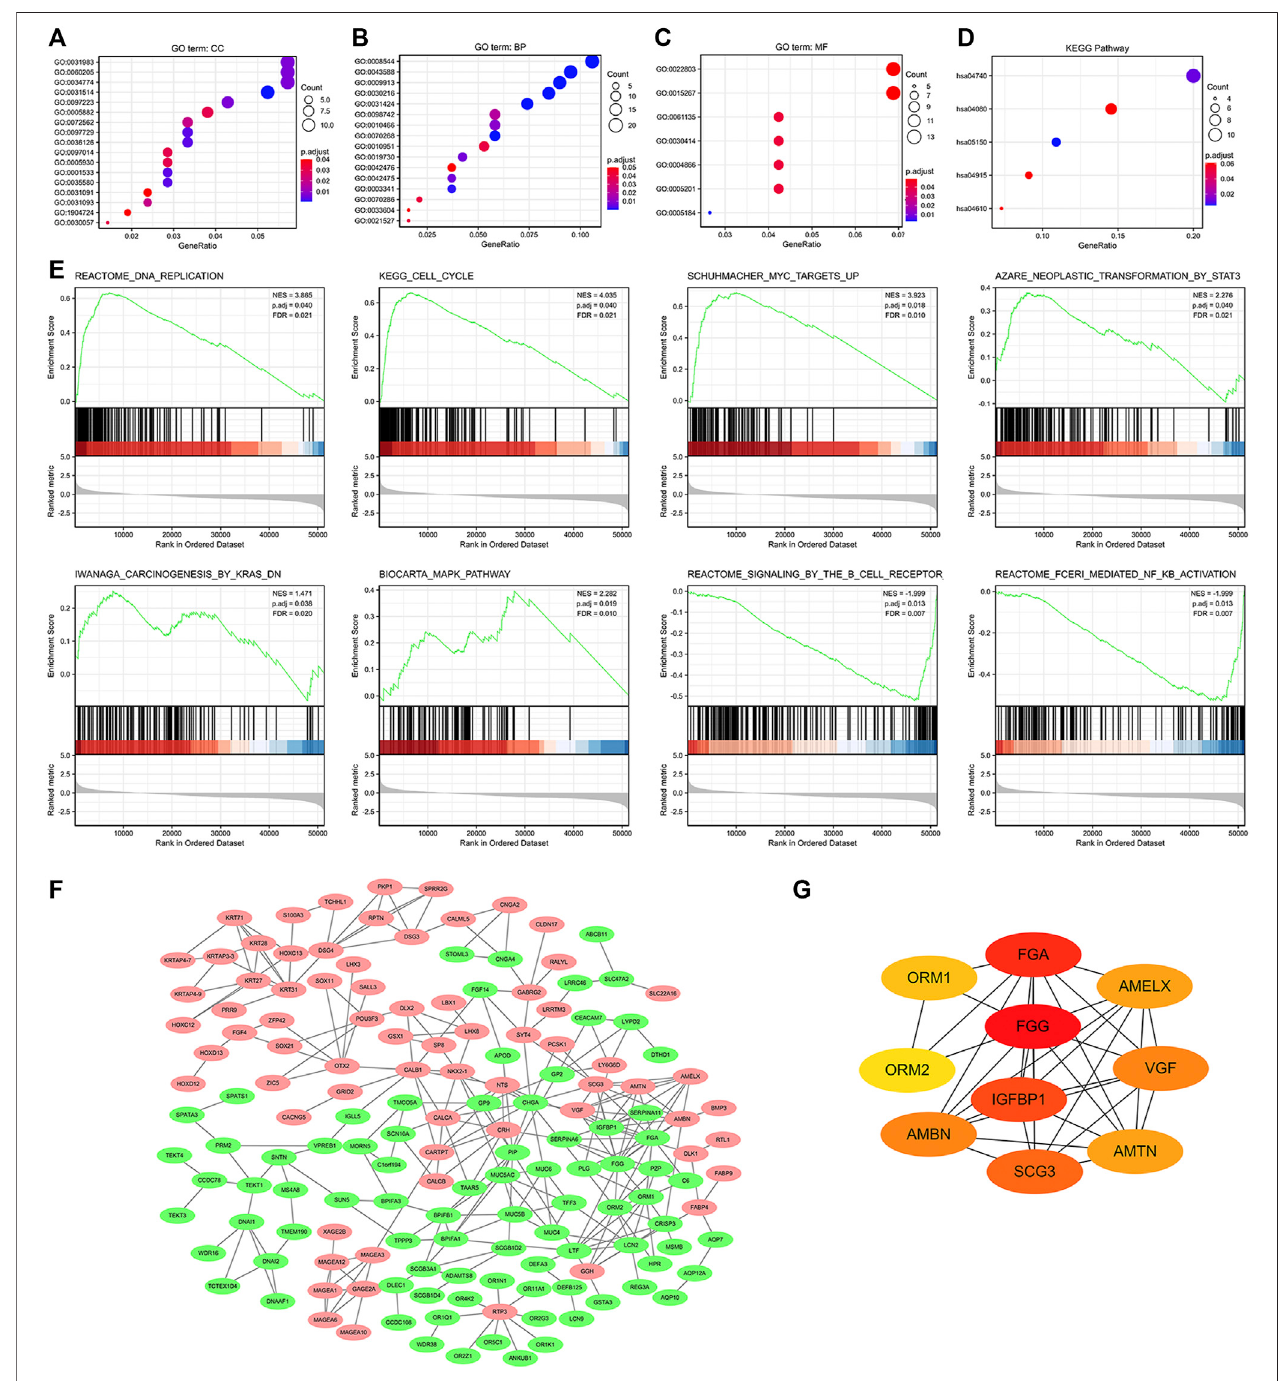
FIGURE7| Functionalenrichmentanalysisof521DEGsbetweenhighandlowGGHexpressionsubgroupsofpatientswithUCECfromTCGA. (A – C) EnrichedGO terms in the “ cellular component ” category (A) , “ biological process ” category (B) , and “ molecular function ” category (C) . (D) KEGG classi fi cation map of DEGs. The x -axis represents the proportion of DEGs, and the y -axis represents the individual GO or KEGG terms. The different colors indicate adjusted p -values, and the different dot sizes represent the number of DEGs associated with each term. (E) Enrichment plots from gene set enrichment analysis (GSEA). Several pathways were differentially enriched in GGH-related genes, including “ FC-gamma receptor (FC γ R), ” “ MHC class II antigen presentation, ” “ oncogenesis by met, ” “ DNA replication, ” “ ubiquitin-mediated proteolysis, ” “ MAPK pathway, ” “ cell cycle, ” and “ endocrine therapy resistance. ” ES, enrichment score; NES, normalized ES; p .adj, adjust p- value; FDR. (F) Visualizedprotein – proteininteractionenrichmentanalysisofDEGs.RedplotsrepresentupregulatedDEGsandgreenplotsrepresentdownregulatedDEGs. (G) Top 10 genes from the PPI network calculated by the MCC method using Cytohubba. Yellow indicates low and red indicates high scores.